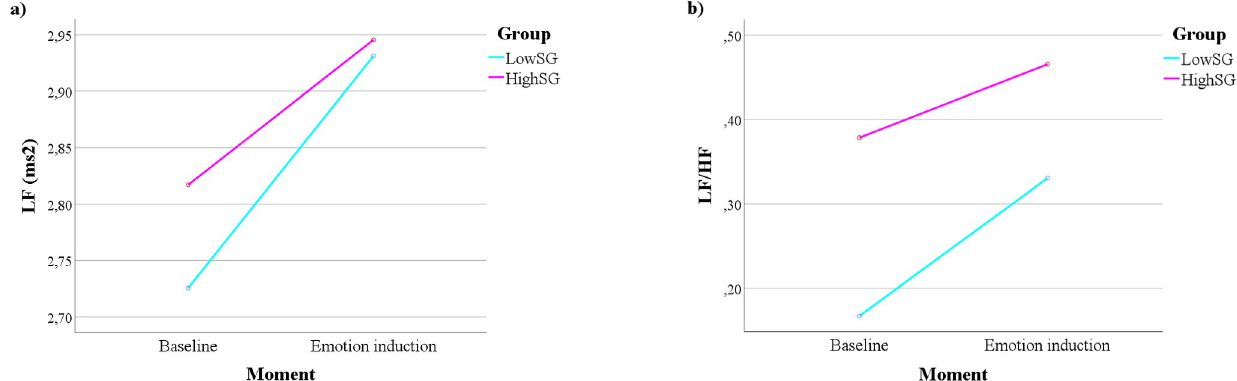
Fig 2. Somatic groups’ differences considering the moment of evaluation. a) LF power and b) LF/HF ratio.